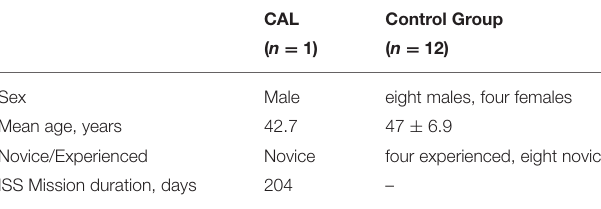
TABLE 1 | Astronaut demographics at baseline